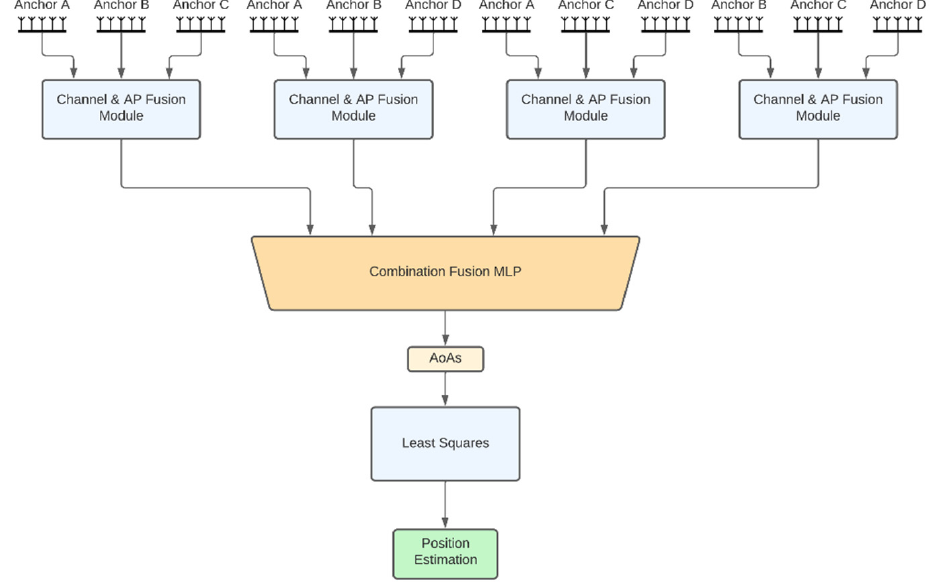
Figure 3. Triplets of APs